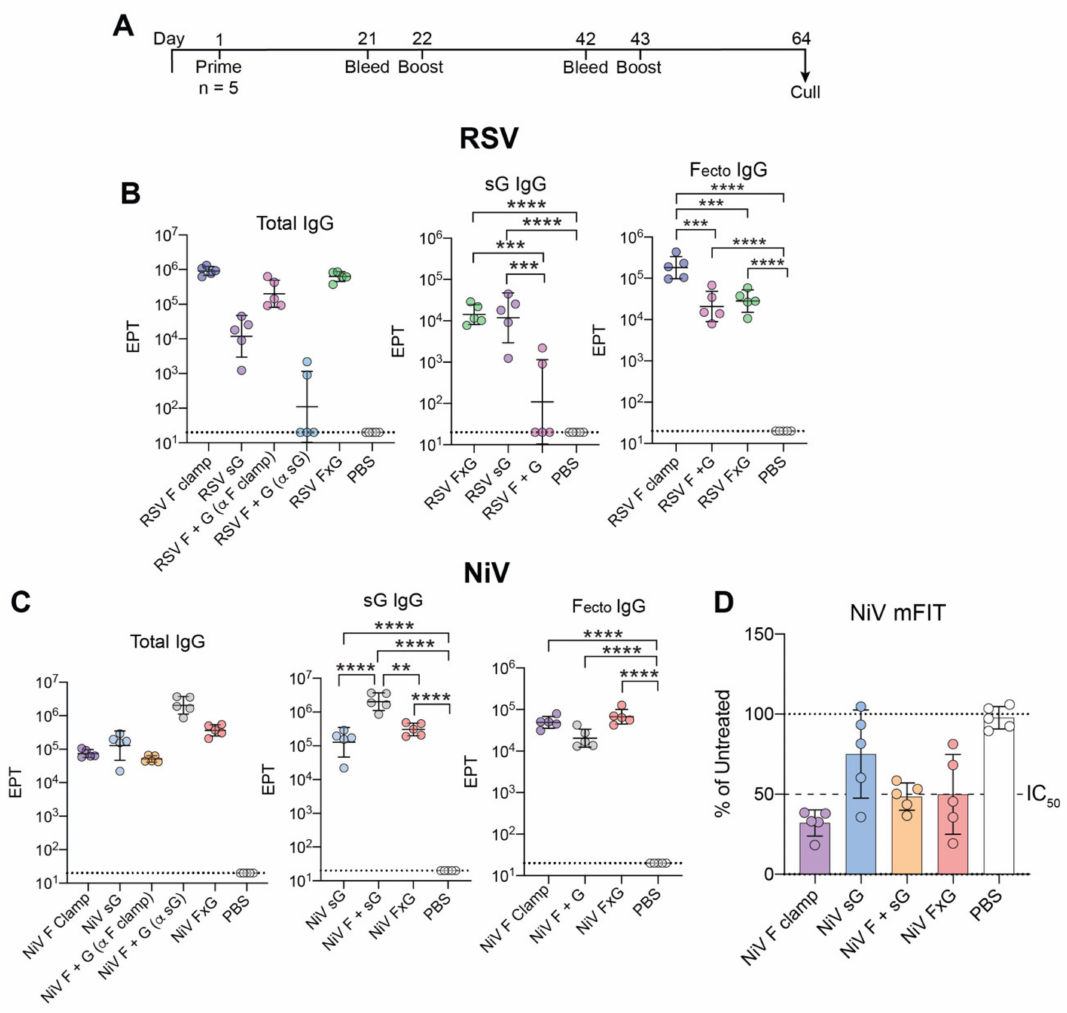
Figure 3. Immunogenicity of terminal bleed sera from NiV and RSV F, G, F + G and FxG vaccination in BALB/c mice. ( A ) Timeline of immunisation regimen employed. ( B ) Endpoint titres (EPT) of each RSV antigen group against vaccinated antigen/s (total IgG), RSV sG & RSV F ectodomain (F ectdo , DsCav foldon). ( C ) EPTs of each NiV antigen group against vaccination antigen/s (total IgG), NiV sG & NiV F ectodomain (F ecto , NiV F foldon). Dotted line shows limit of detection and data is expressed as geometric mean with geometric standard deviation (SD). p -values calculated using a one-way Tukey’s multiple comparison ANOVA on log transformed values, where * = p < 0.05, ** = p < 0.005, *** = p < 0.0005 and **** = p < 0.0001. ( D ) NiV-mFIT of a 1:40 dilution of serum samples from respective antigen groups. Data is expressed as a percentage of the average luciferase readings seen in untreated (no serum) controls with 50% inhibition (IC 50 ) indicated as a dashed line. Each sample was assayed in triplicate with group mean and SD